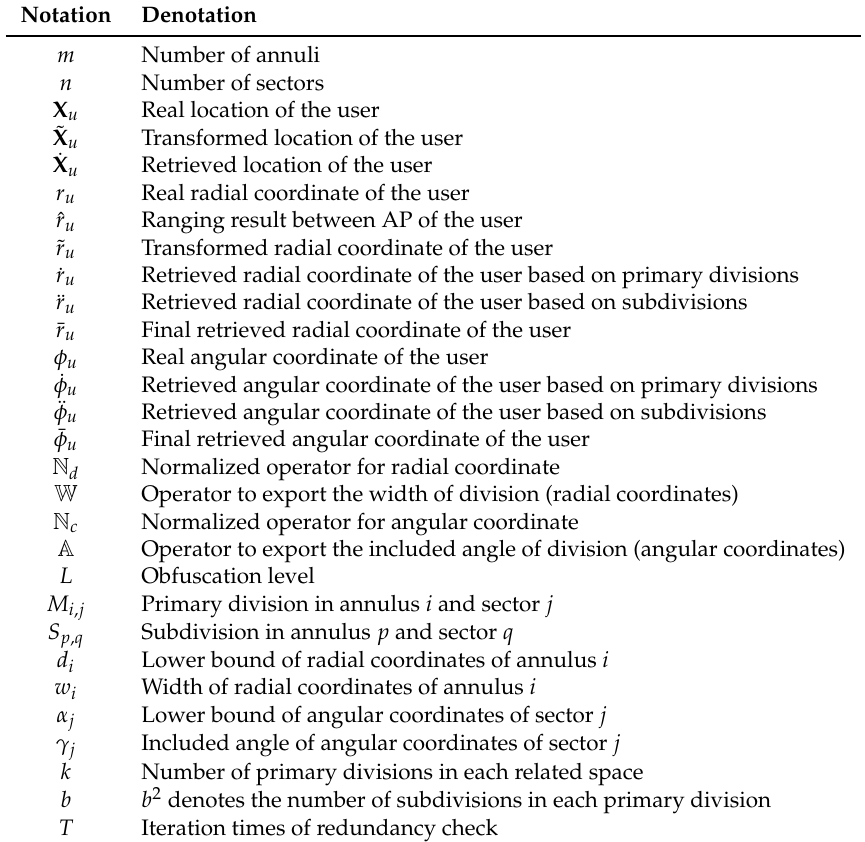
Table 1. List of